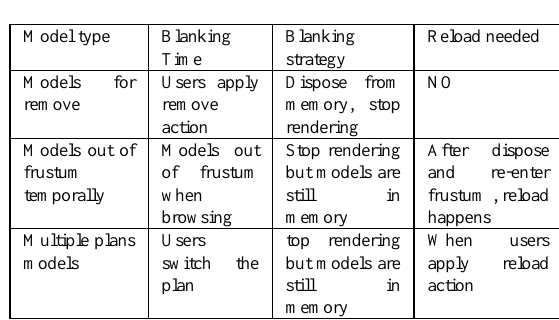
Table1: Different conditions and situations of